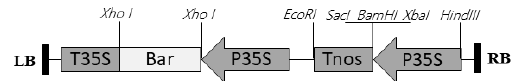
Figure 2. T-DNA region of the expression vector pCAMBIA3300-35S-bar, containing a selectable marker gene bar (phosphinothricin acetyl transferase) driven by the cauliflower mosaic virus 35S promoter (P35S).